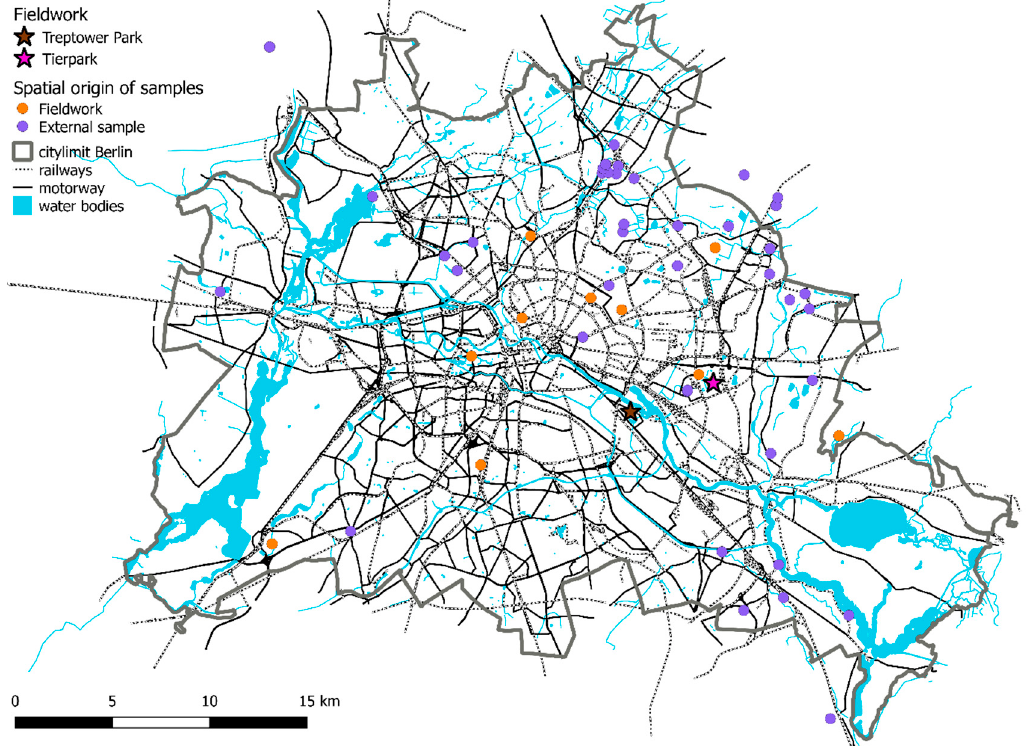
Figure 1. Map of Berlin and its surroundings and showing the locations from 139 out of 143 samples (four samples not shown because locations are outside of map). External samples: samples received from rescue centres. Their locations need to be viewed with caution. Samples from “Tierpark” and from‚ “Treptower Park” are lumped under pink and dark stars, respectively.